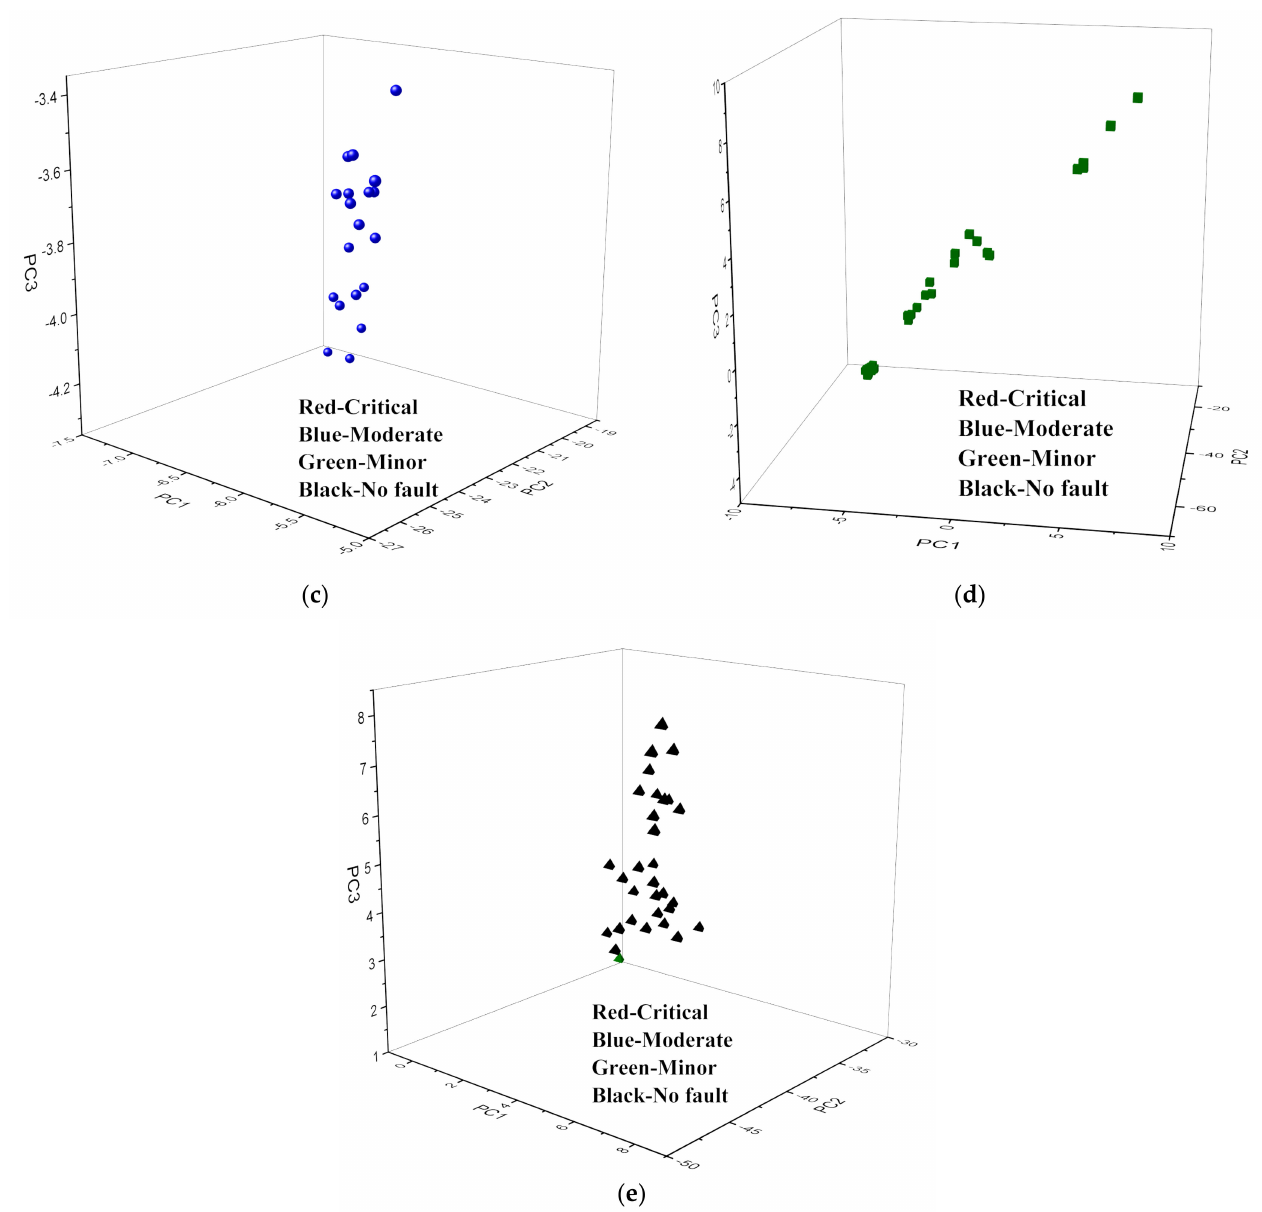
Figure 5. Fault grading performance based on ANN: ( a ) Overview; ( b ) Critical fault; ( c ) Moderate fault; ( d ) Minor fault; ( e )